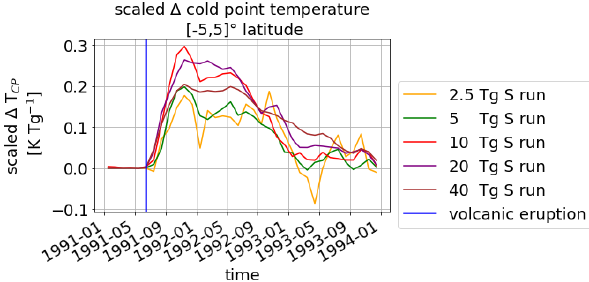
Figure A3. Scaled temporal evolution of the mean CP temperature anomaly. The time of the volcanic eruption is indicated by a vertical blue line. All changes in cold-point temperature are divided by the mass of emitted sulfur.